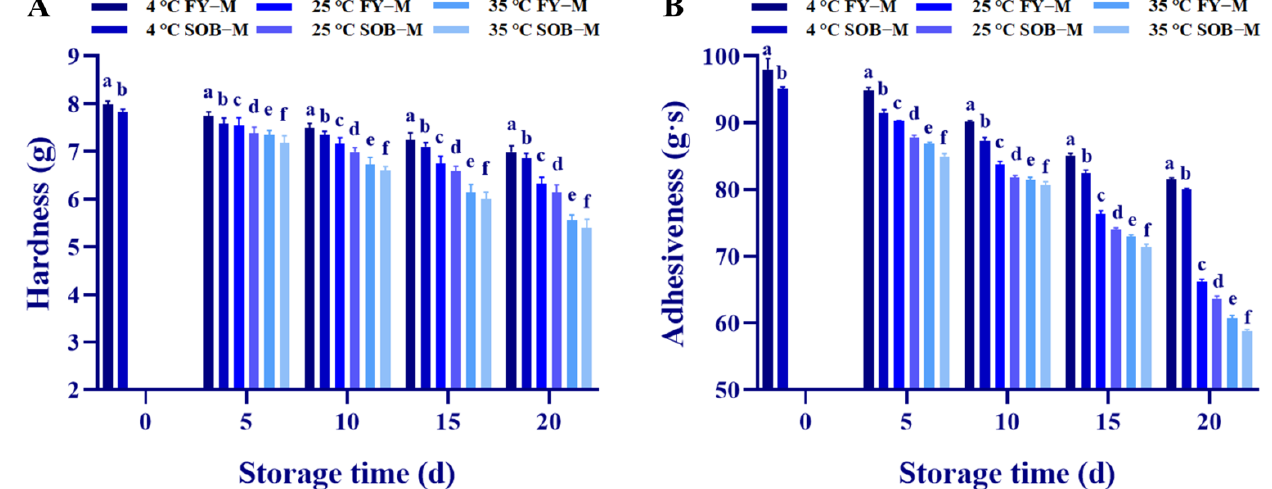
Figure 4. Effects of different stabilizers on ( A ) hardness, ( B ) adhesiveness of full egg yolk mayonnaise (FY − M) and SOB-substituted mayonnaise (SOB − M) during storage. Different lowercase letters indicated a significant difference ( p < 0.05).